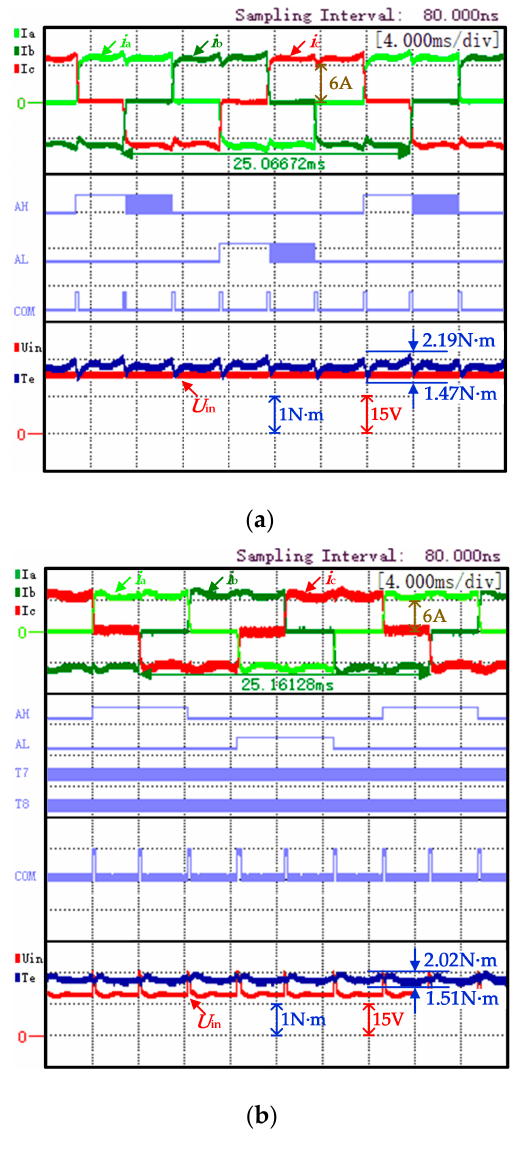
Figure 12. The experimental results with light load condition: ( a ) traditional strategy; and ( b ) proposed strategy.